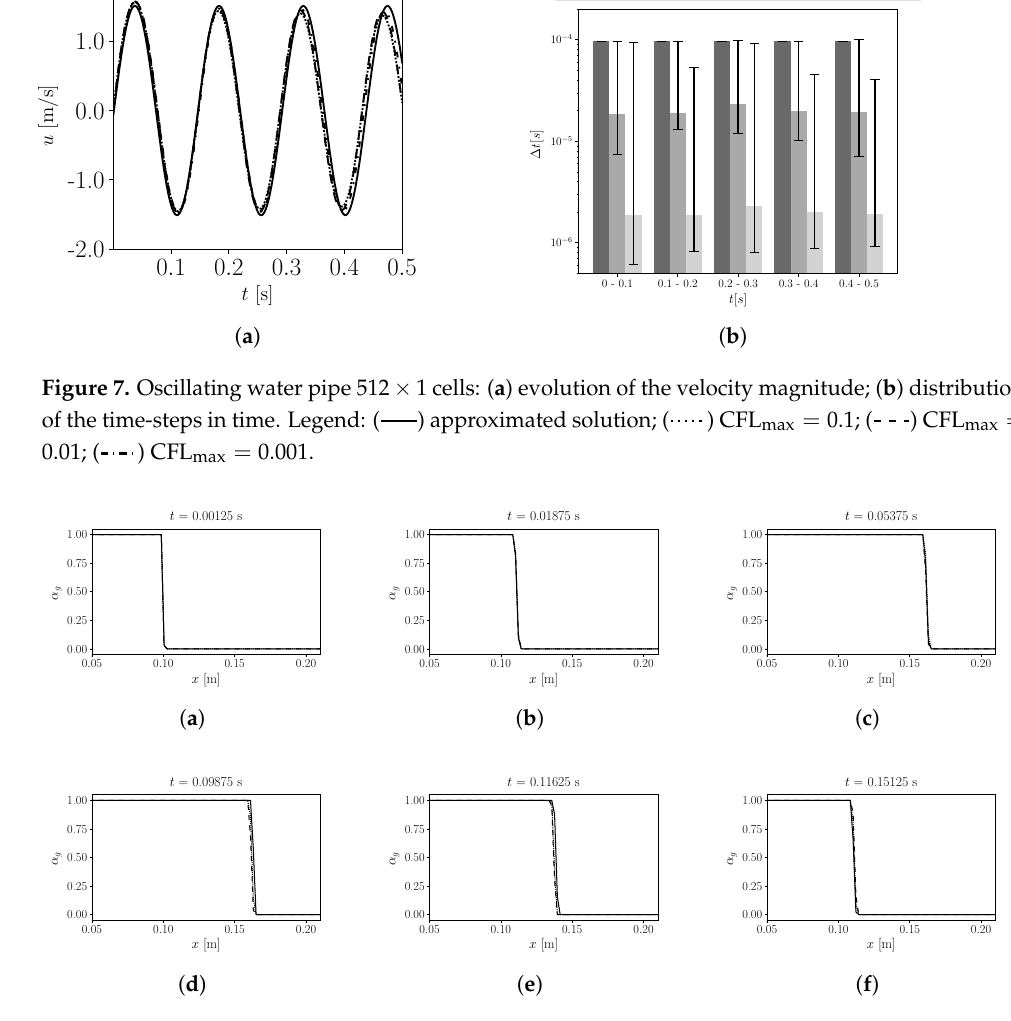
Figure 8. Oscillating water case: evolution of the left liquid–gas interface for different values of CFL max ; time evolution from right to left (( a – c ) and ( d – f )). Grid size 512 CFL max = 0.001; (